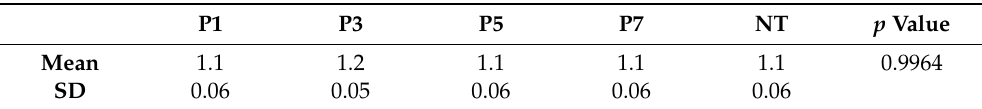
Table 2. Mean and Standard Deviation (SD) of DNA index (DI) obtained for HGF cells exposed to He-CAPP for 1, 3, 5, and 7 min (P1 to P7).